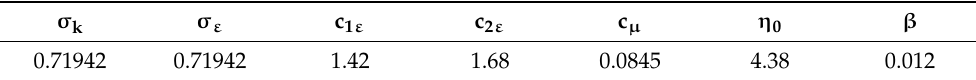
Table 1. The values of the model